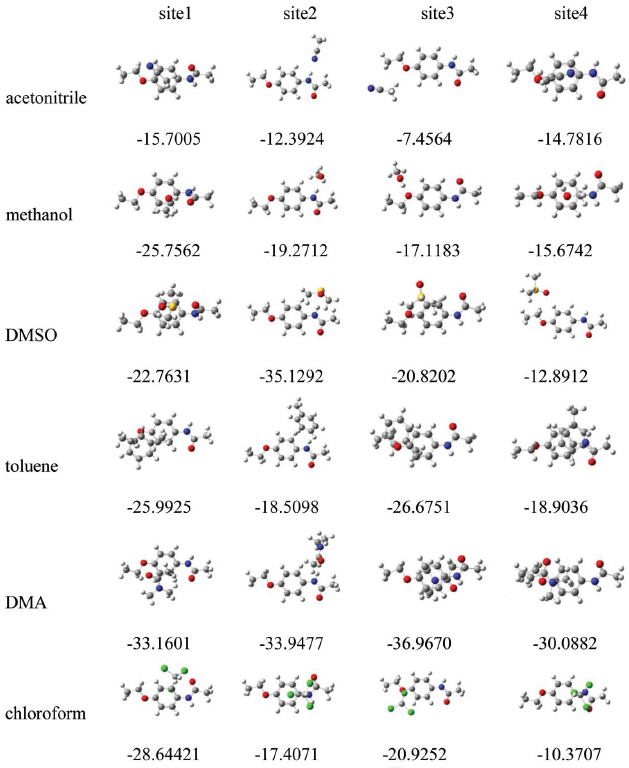
Figure 12 Optimized geometries and binding energies (kJ mol (cid:5) 1 ) for 1:1 PHEN– solvent complexes, calculated at the M062X/6-311G (d,p) level. Carbon – grey, hydrogen – white, oxygen – red, nitrogen – blue, sulfur – yellow, chlorine –